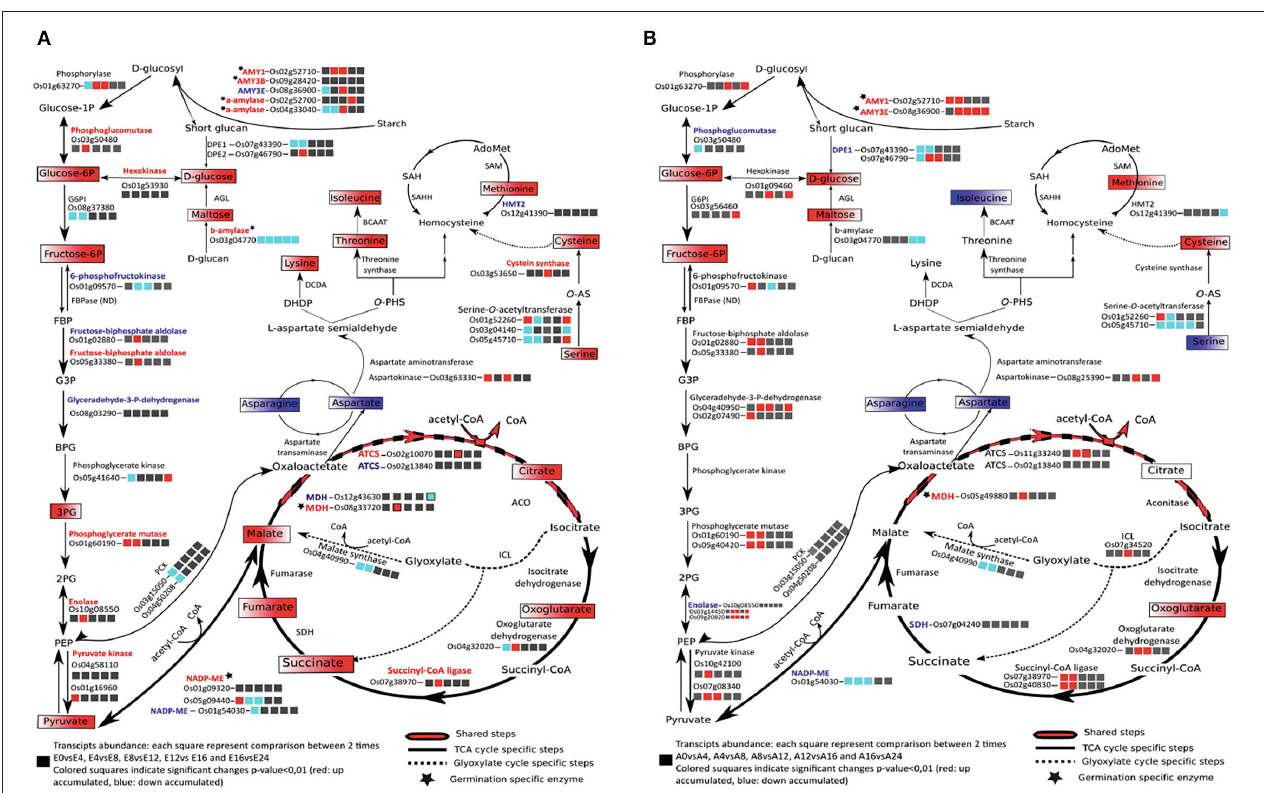
FIGURE 5 | Metabolic pathways related to seed glycolysis/neoglucogenesis, energy, and amino acid metabolisms in rice embryo (A) and rice endosperm (B) comparing mature dry and germinated seeds. Up and down-accumulated metabolites during germination are displayed, respectively, in red and blue boxes. Proteins present in the total embryo proteome are indicated in black if not detected or if their abundance change was not significant. ACO, aconitase; AGL, alpha-glucosidase; ATCS, citrate synthase; BCAAT, branched-chain-amino-acid aminotransferase; DCDA, diaminopimelate decarboxylase; DHDP, dihydrodipicolinate; DPE, depolymerizing enzyme; FBP, fructose-1,6-bisphosphate; G3P, glycerate-3-phosphate; HMT2, homocysteine S -methyltransferase; ICL, isocitrate lyase; MDH, malate dehydrogenase; NADP-ME, NADP-malic enzyme; O- PHS, O- phospho-L-homoserine; PCK, phosphoenolpyruvate carboxykinase; PEP, phosphoenolpyruvate; 3PG, 3-phosphosphoglycerate; O- AS-, O- acetylserine; SAH, S- adenosyl-L-homocysteine; SAHH, S- adenosyl-L-homocysteine hydrolase; SAM2, S- adenosylmethionine synthetase; SDH, succinate dehydrogenase; TCA, tricarboxylic